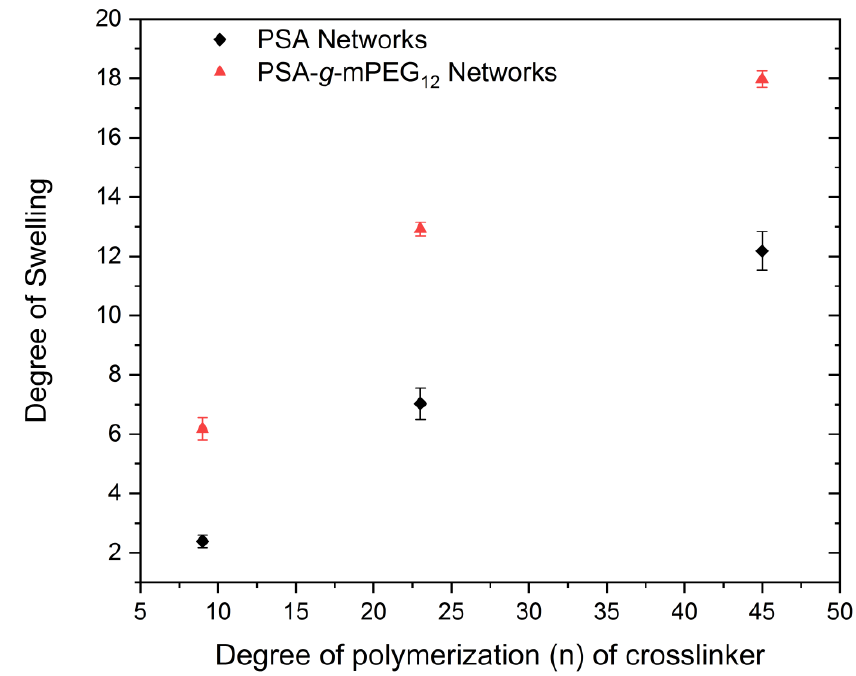
Figure 5. Degree of swelling of PSA and PSA- g -mPEG 12 based networks as a function of degree of polymerization (n) in D 2 O at room temperature.